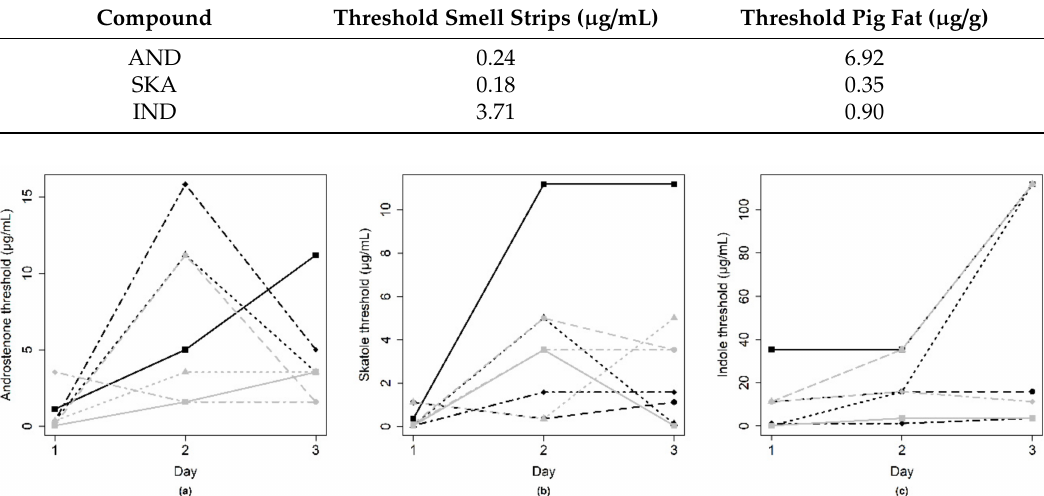
Table 4. Olfactory detection thresholds for AND, SKA, and IND. Determined for 6 trained panelists using smell strips and spiked pig fat.